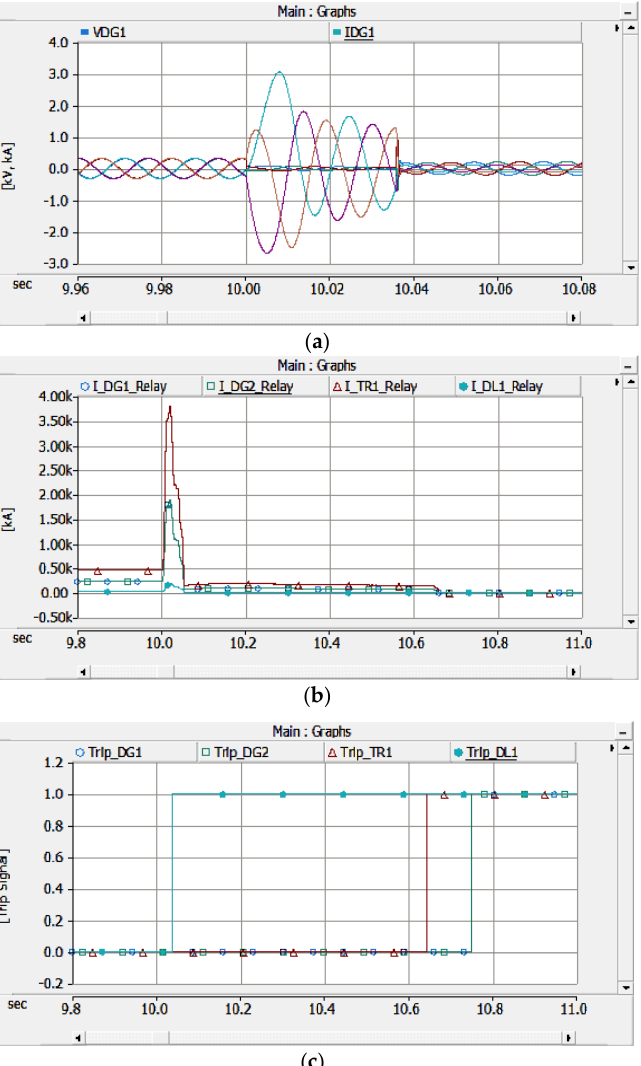
Figure 10. Simulation results of Case #1: ( a ) voltage and current of diesel generator #1; ( b ) current of each relay; ( c ) trip signal of each relay.